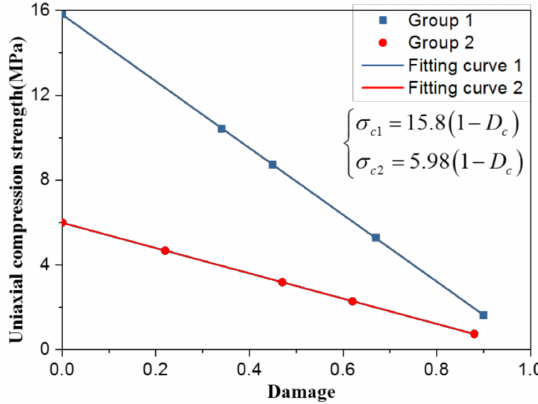
Figure 6. Relationship between uniaxial compressive strength and